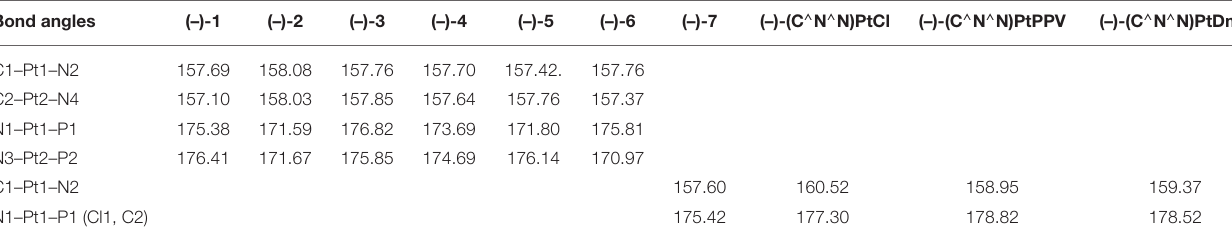
TABLE 2 | Bond angles around the Pt(II) nucleus of the opitimized configurations obtained from calculation. Bond